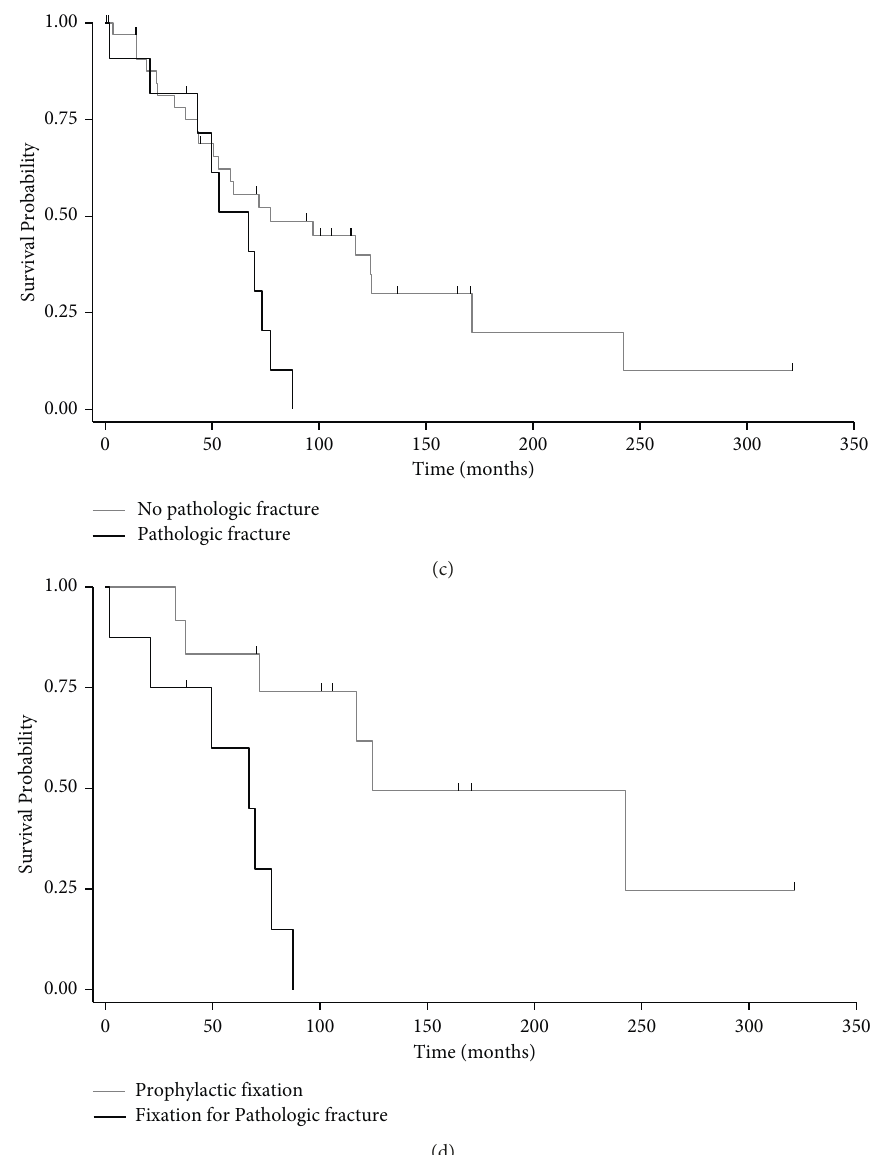
Figure 5: Kaplan–Meier survival analysis of patients with metastatic leiomyosarcoma according to subtypes of LMS, p � 0 . 56 (a); surgical intervention for bone metastases, p � 0 . 06; (b) pathologic fracture of bone metastases, p � 0 . 04 (c); indication for fixation, p � 0 . 002 (d). Vertical hash marks represent censored